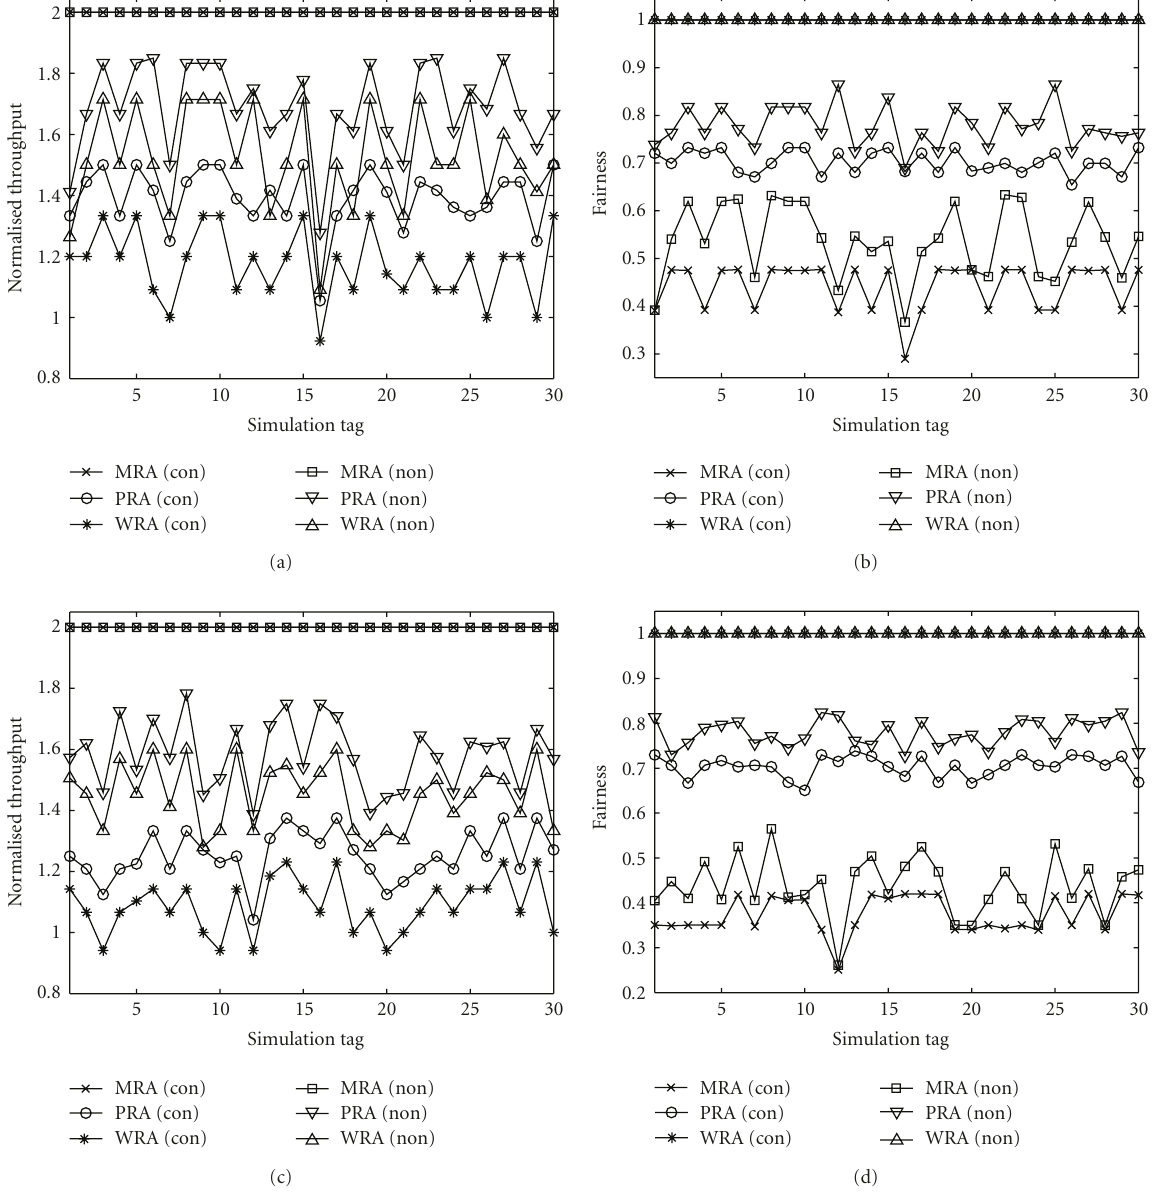
Figure 7: Throughput and fairness results for the di ff erent network scenarios: (a) throughput for the 6-node topologies, (b) fairness for the 6-node topologies, (c) throughput for the 10-node topologies, and (d) fairness for the 10-node